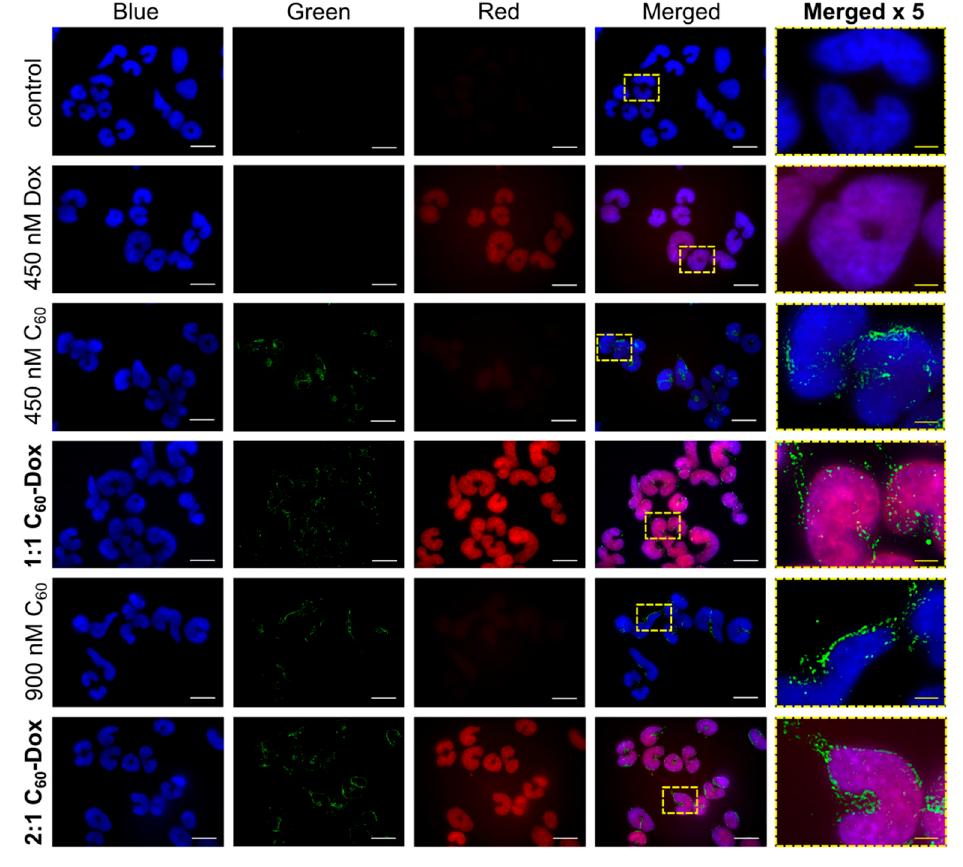
Figure 4. Fluorescence microscopy images of CCRF-CEM cells, stained with 4 ′ ,6-diamidine-2 ′ -phenylindole dihydrochloride (DAPI, Blue), fluorescein isothiocyanate-based immunostaining for C 60 (Green) and Dox (Red) after treatment with: 450 and 900 nM C 60 , 450 nM Dox, 1:1 or 2:1 C 60 -Dox nanocomplex. The white scale bar corresponds to 20 µm; the yellow scale bar on images in the column “Merged x5” corresponds to 4 µm.